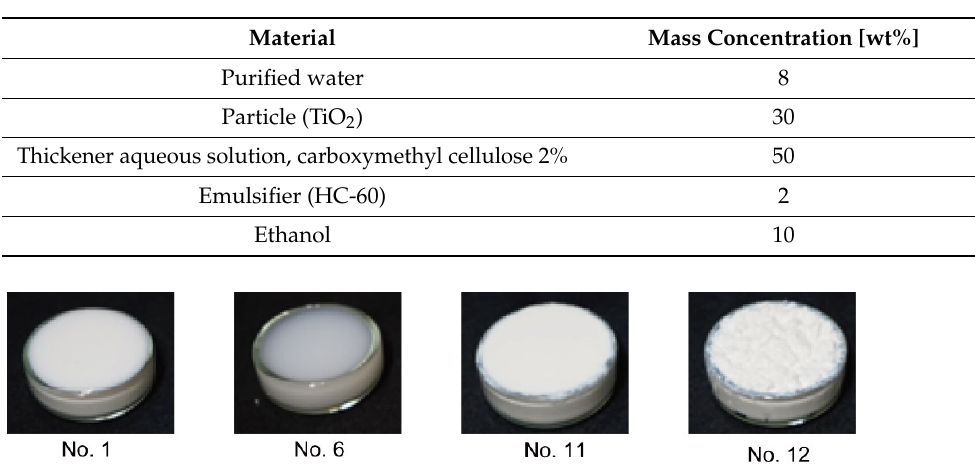
Table 4. Components of the sample Nos. 11–12.